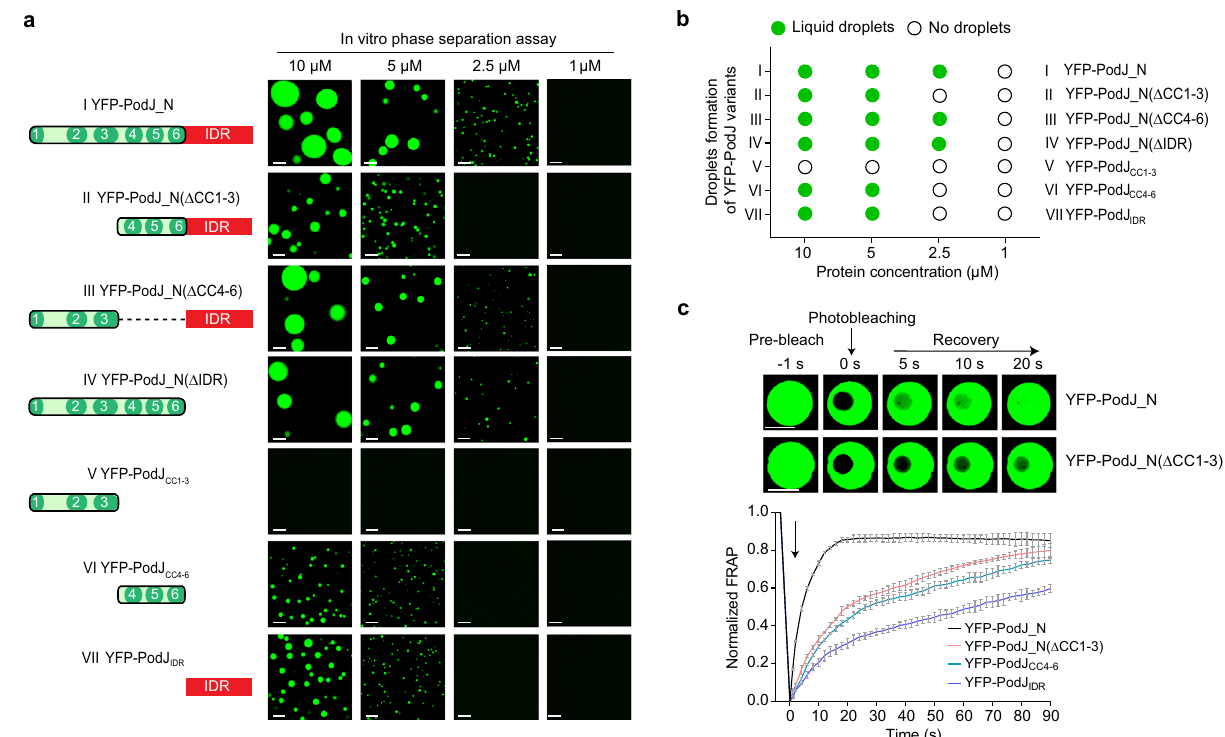
Fig. 3 | Either IDR or CC4 – 6 can mediate PodJ phase separation in vitro. a Droplet formation for the truncated YFP-PodJ_N proteins. Images were taken within15minafterloading1,2.5,5,or10 µ MYFP-PodJ_Nanditsvariantsontheglass pad at 25°C. b Summary of droplet formation by YFP-PodJ_N and the variants in panel a . c ComparativeFRAPanalysisrevealsafaster fl uorescencerecoveryforYFP- PodJ_N droplets than for YFP-PodJ_N( Δ CC1 – 3) droplets. The recovery curves for